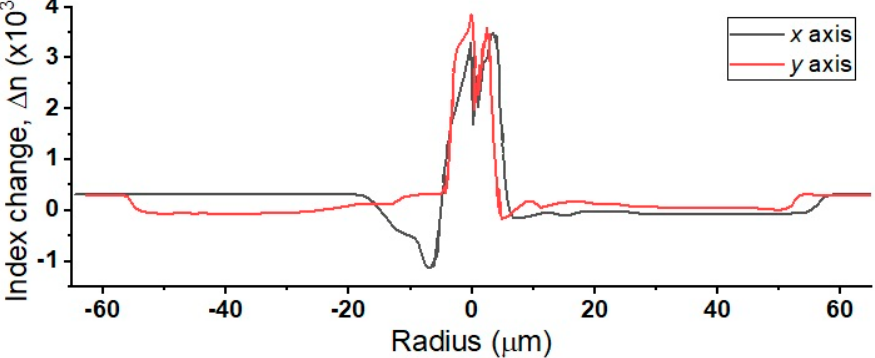
Figure 5. Index profile of a C-Shaped optical fiber along the x and y axes.